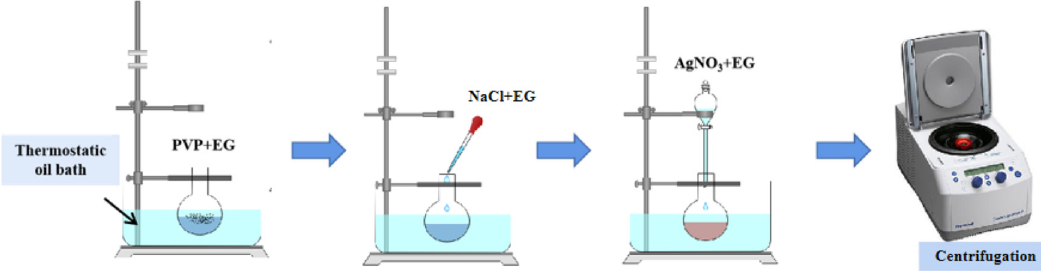
Fig. 1. The preparation schematic diagram